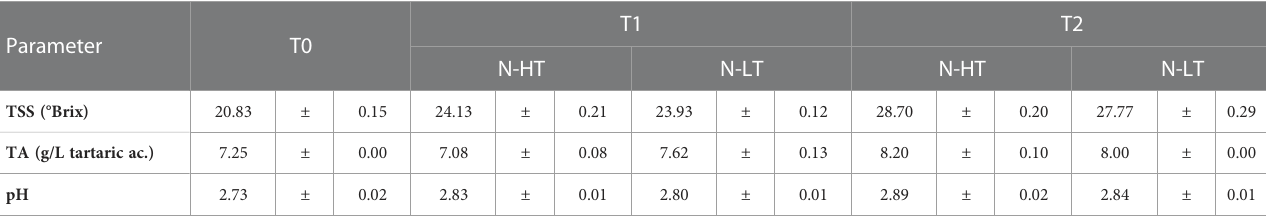
TABLE 2 Total soluble solids (TSS), total acidity (TA) and pH measured in grapes dehydrated in the N-HT and N-LT facilities at sampling time points T0, T1 and T2).